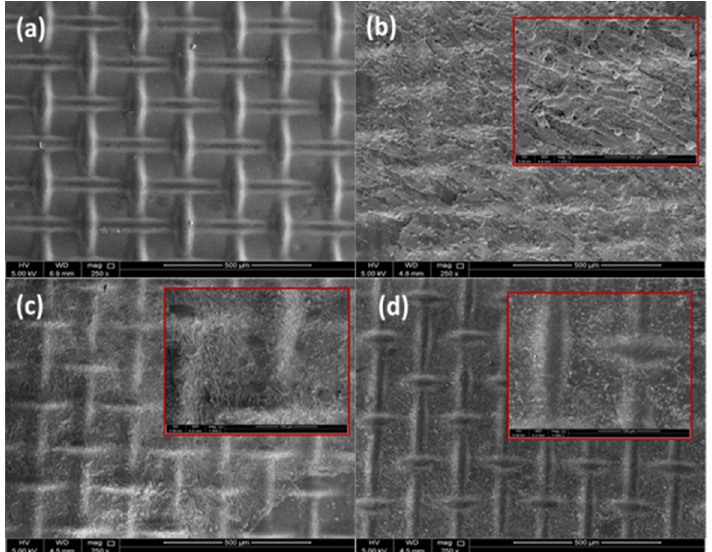
Figure 5. Cross-sectional SEM image of the active layer surface of the CTA FO membrane after three consecutive FO runs: l ( a ) origin; ( b ) without physical cleaning; ( c ) in situ flushing; and ( d ) osmotic backwash. Conditions: FS = SWW, DS = MCFDS (300 g/L) and FS and DS flowrate = 1.6 LPM at room temperature for 24 h operating time.